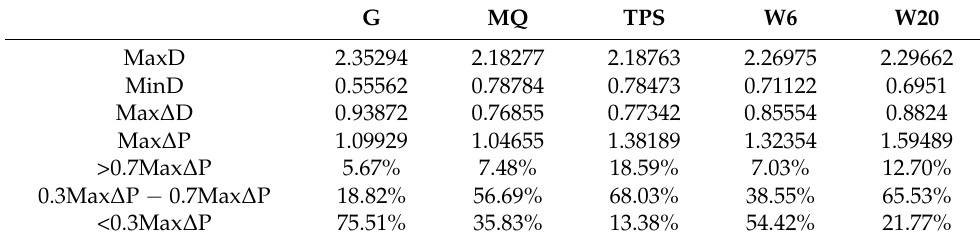
Figure 7. Arbitrary modification results obtained using the basis functions. Table 8. Comparison of the modification